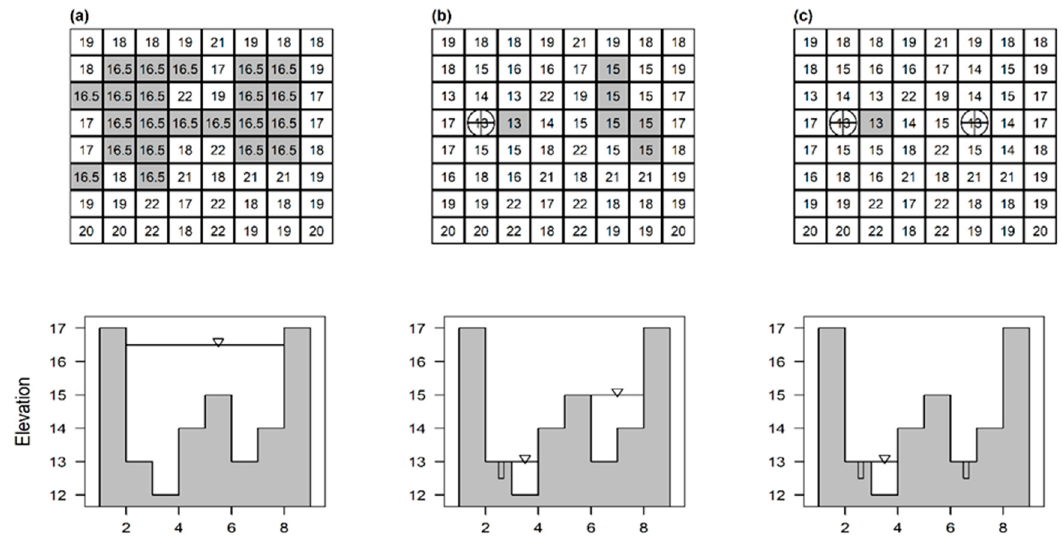
Figure 3. Schematic representation of flood recession processes from a single and multiple manhole. ( a ) Represent the areal extent and profile section of the flooded regions, ( b ) represents the areal extent and profile of flood recession for a single manhole, and ( c ) show a recession surface and profile after drained by two manholes.